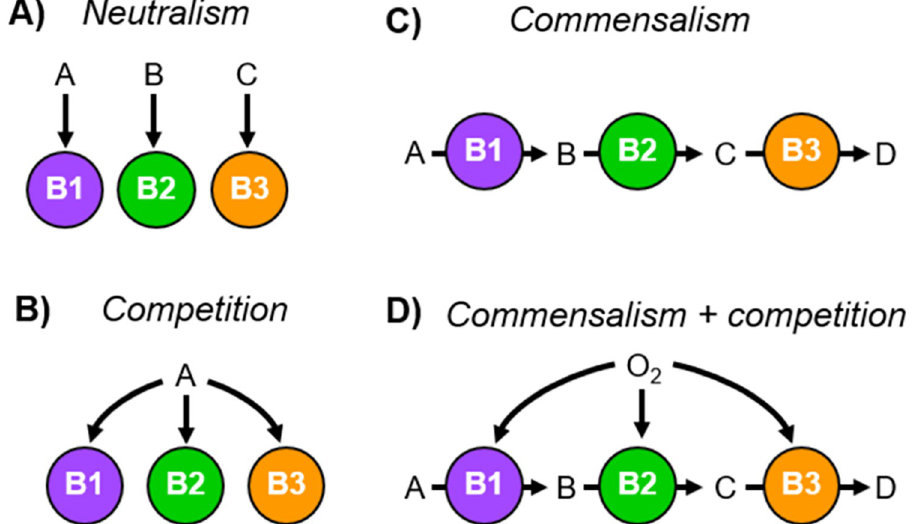
Fig 10. Representation of eco-interactions among B1 (purple), B2 (green) and B3 (orange). (A) Neutralism: [0,0,0]; no impact on B1, B2 and B3. (B) Competition: [–,–,–]; negative impact on B1, B2 and B3. (C) Commensalism: [0,+,+]; no impact on B1, positive impact on B2 and B3. (D) Commensalism + competition: [0,+,+] or [–,–,–]; impact on B1, B2 and B3 is defined by the environment.